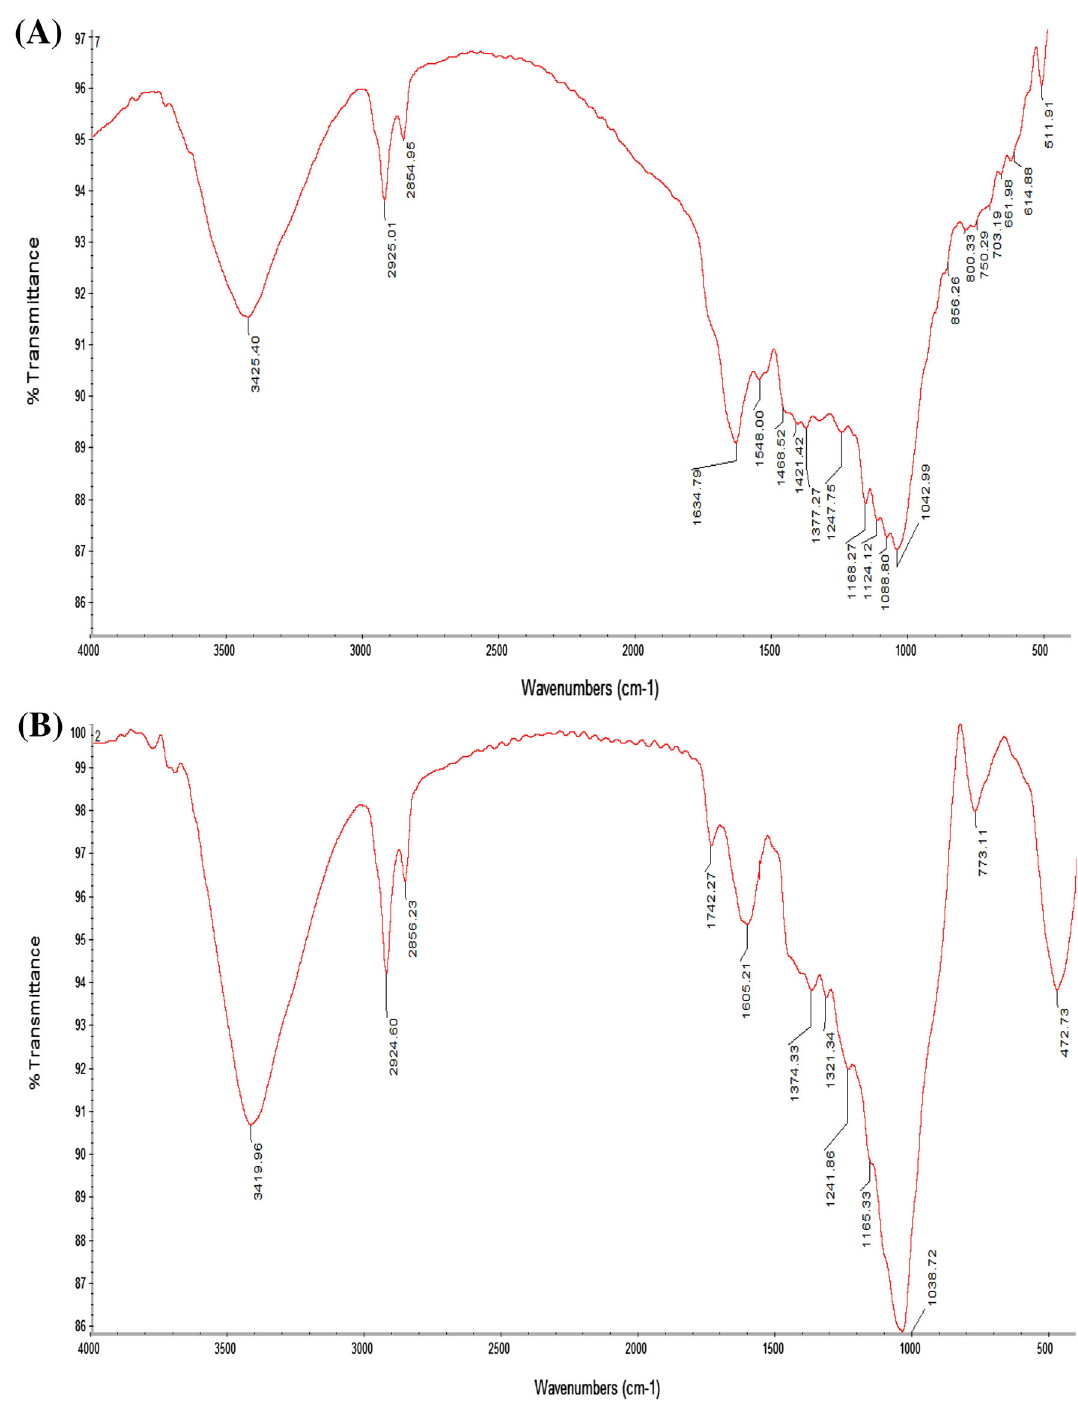
Fig. 4 FTIR analysis of a untreated saw dust and b laccase (from Trichoderma harzianum strain HZN10)-treated saw